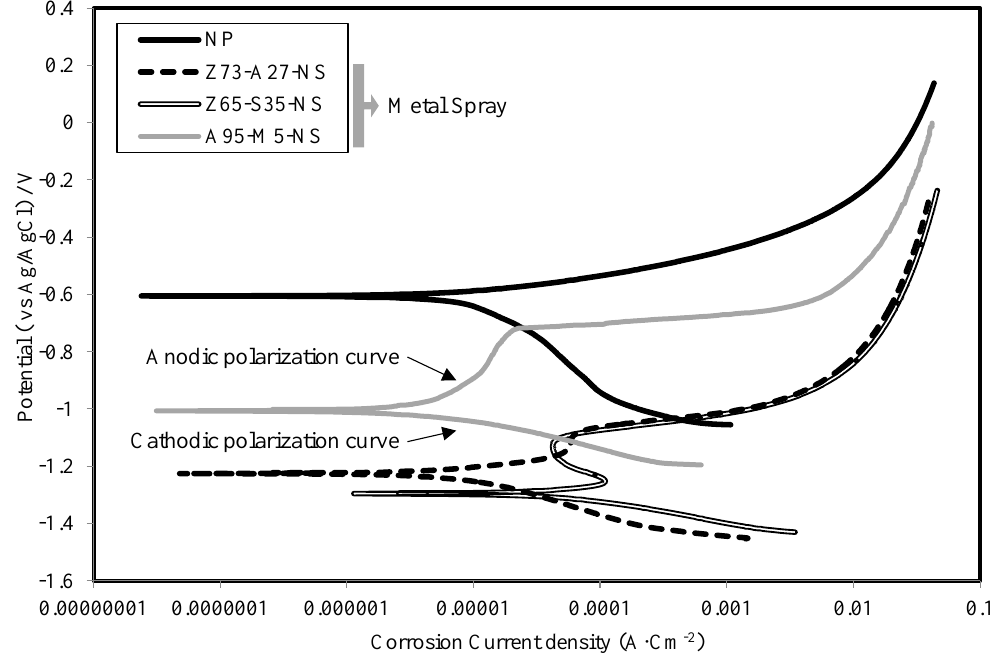
Figure 6. Polarization curves of NP, Zn–Al, Zn–Sn and Al–Mg specimens.